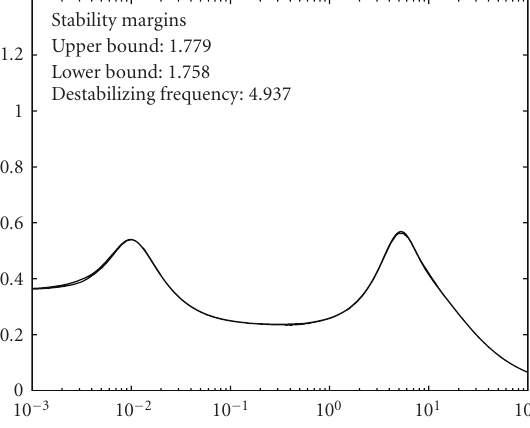
Figure 6: Stability margin bounds for longitudinal